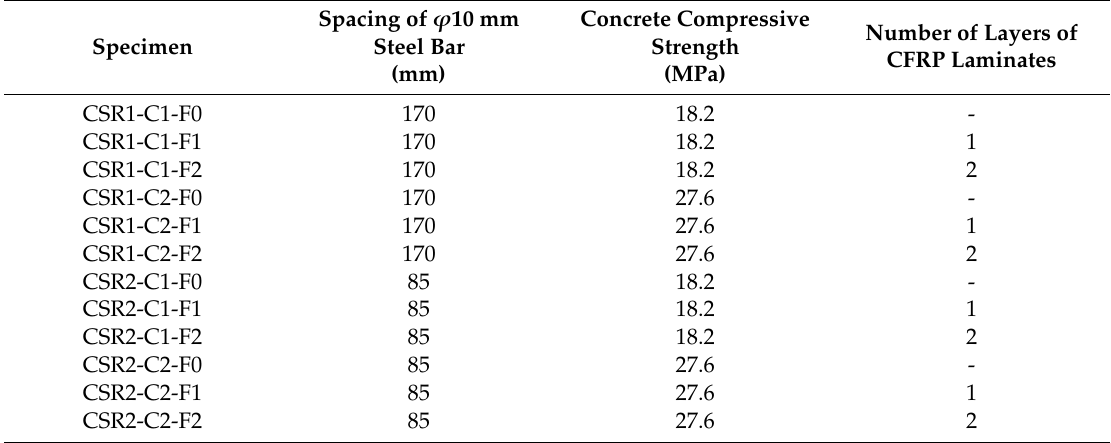
Table 1. Specimens test matrix. CFRP: carbon fiber reinforced polymer.